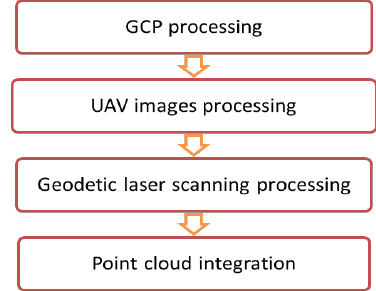
Figure 5 Flowchart in data processing